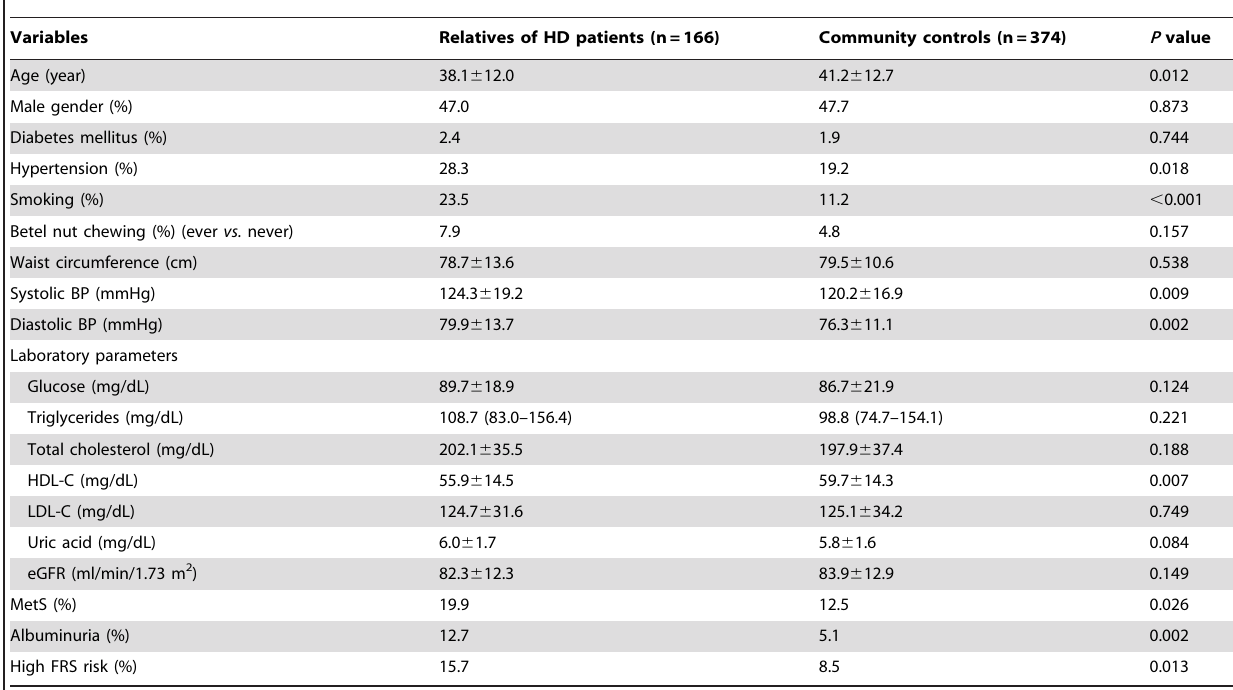
Table 1. Comparison of baseline characteristics between relatives of HD patients and community